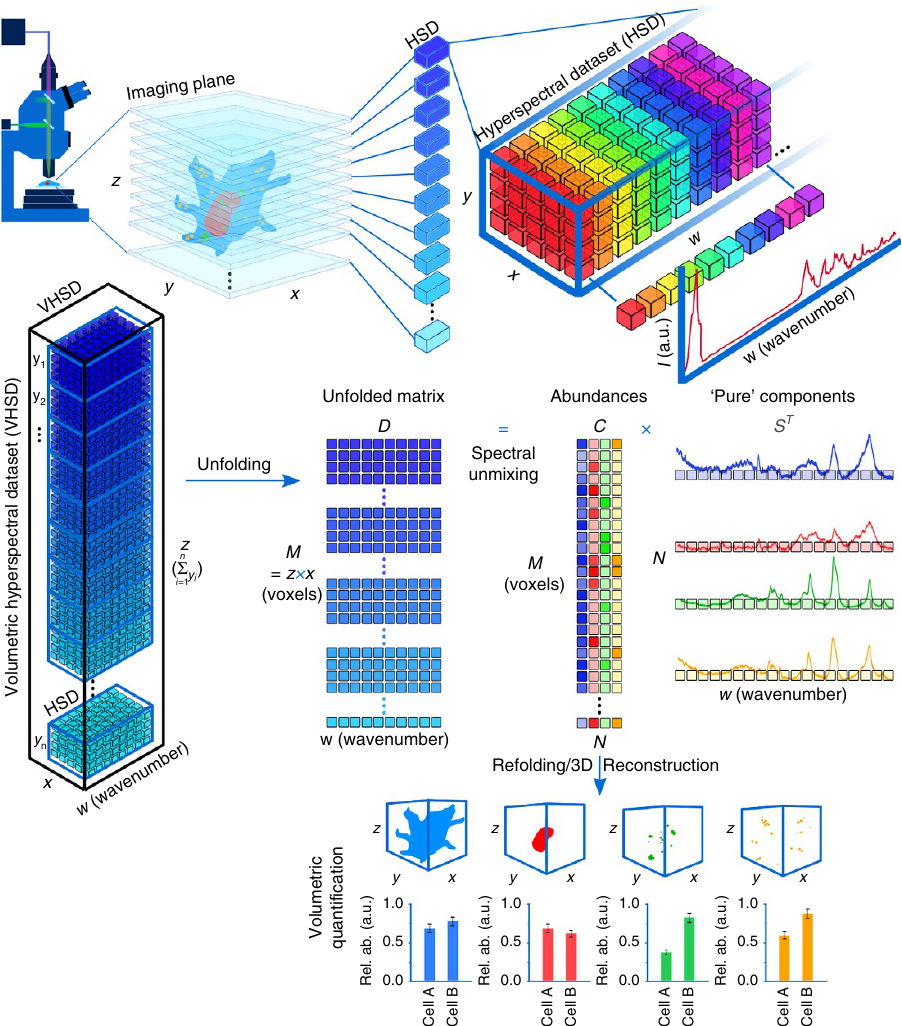
Figure 1 | Schematic illustration of qVRI imaging process, from data collection and spectral unmixing to 3D reconstruction and quantification. The confocal microscope provides control over x (cid:3) y (cid:3) z dimensions of the sample position for 3D imaging. Each imaging plane is described by a hyperspectral dataset. Hyperspectral datasets are 3D datasets with x (cid:3) y (number of pixels in a single imaging plane) spatial dimensions and w (wavenumbers) spectral dimension. Each voxel in 3D is associated with a single Raman spectrum. Combining hyperspectral datasets from multiple imaging planes creates a volumetric hyperspectral dataset with z (cid:3) x spatial dimensions and z being equal to the sum of y n imaging planes. For spectral unmixing analysis the volumetric hyperspectral dataset is unfolded to form a matrix D ¼ M (cid:3) w with M ¼ z (cid:3) x . D is unmixed using N number of ‘pure’ components (e.g., here N ¼ 4) into two matrices C and S T . C contains the relative abundance values of the pure components in each voxel in an M (cid:3) N matrix with every column associated to one component. S T is an N (cid:3) w matrix containing a ‘pure’ component spectrum in every row. Each column of C contains all the spatial information needed to reconstruct every components’ 3D architecture by refolding it to the original x (cid:3) y (cid:3) z dimensions. Each voxel contains the concentration profile of the reconstructed component. The number of voxels within an isosurface at a chosen threshold can be used as a metric for quantification, comparing experimental conditions (e.g., comparing Cell A to Cell (PLPs) and cholesterol esters (Fig. 3) 29 . We reconstructed each of the biochemical components identified (Fig. 3a). TAGs were present in dense lipid bodies in the cytoplasm. We identified PLPs located at the cell membrane as well as very small cholesterol rich regions possibly localized inside endosomes. The extracted cytoplasm typical phenylalanine and amide bands expected from cellular structures. The three lipid types all show strong CH 2 twists (1,300 or 1,303 cm (cid:2) 1 ) and blue shifted CH 2 deformation (1,443 cm (cid:2) 1 ) compared to protein rich regions, like the cytoplasm and nucleus. TAG spectra show the characteristic C ¼ O stretching (1,747 cm (cid:2) 1 ) (not present in fatty acids) and some low intensity vibrations around 850–890 cm (cid:2) 1 (not present in cholesterol ester and membrane lipids), which could be related